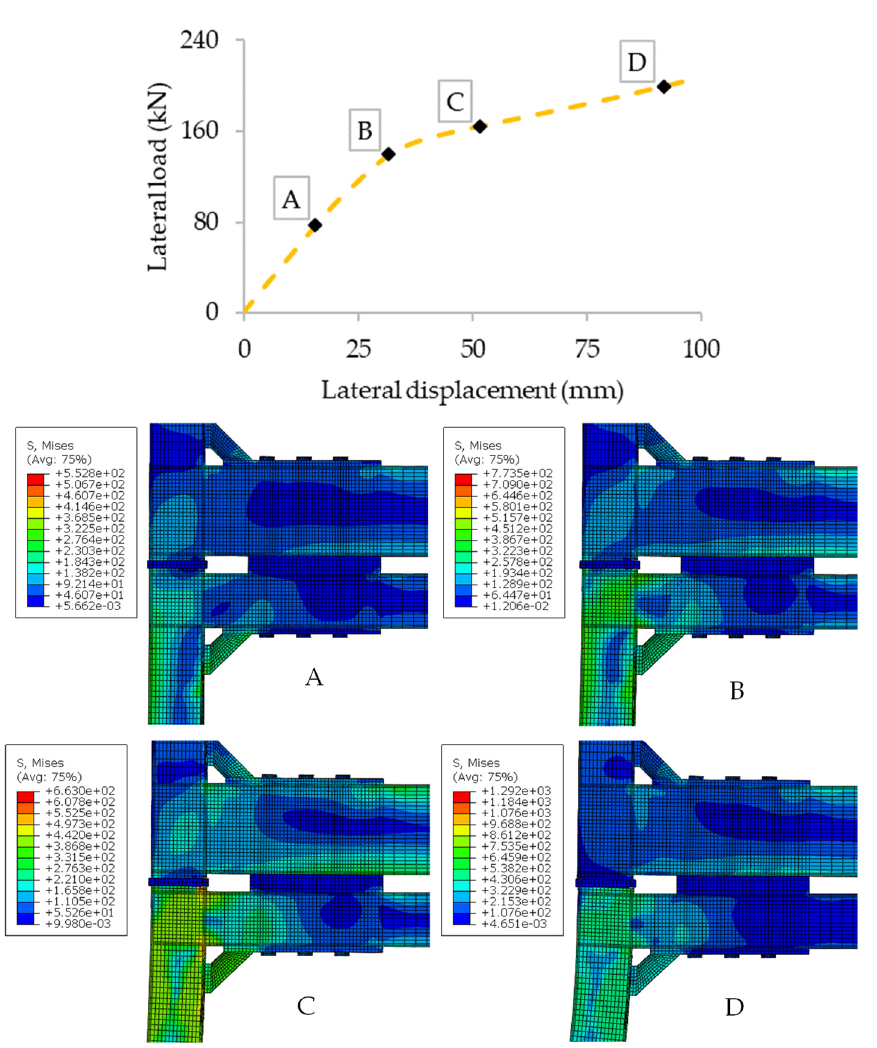
Figure 9. Response of the partially WAAM 3DMBC to the lateral loading.